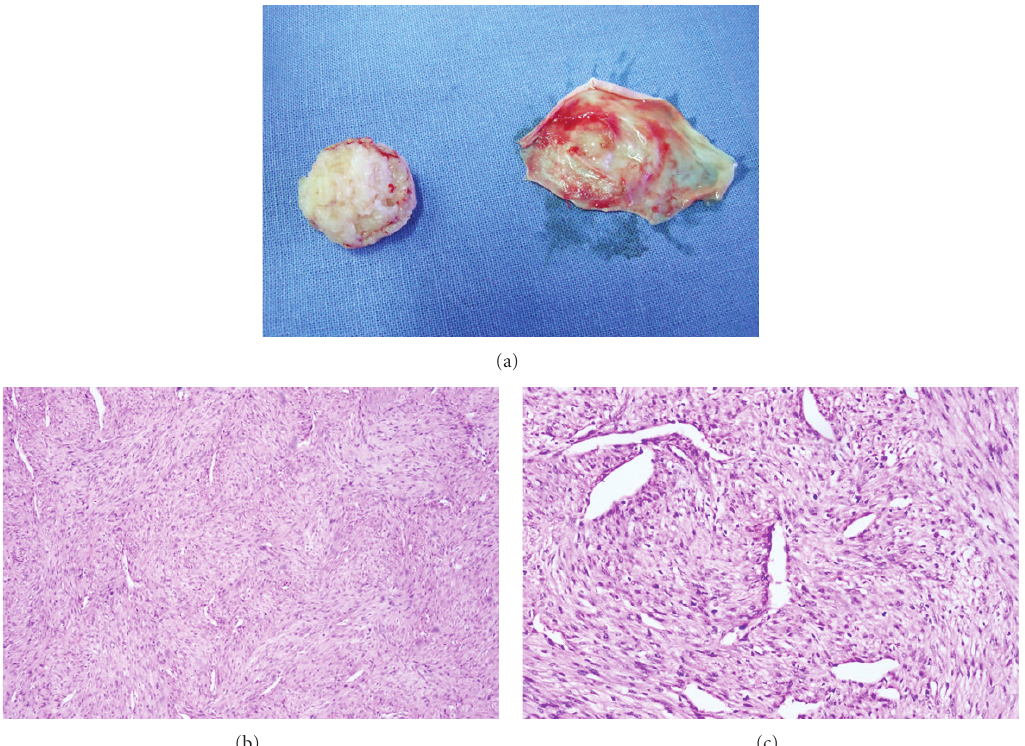
Figure 4: Excised specimen showing the periosteal lining (a), Photomicrograph showing tumour cells arranged in a biphasic pattern (H/E, × 40) (b), Photomicrograph showing light staining areas composed of plump myoid spindle cells arranged in short fascicles with elongated/cigar-shaped nuclei and dark staining areas composed of round or polygonal cells with slightly pleomorphic hyperchromic nuclei (H/E, × 100)